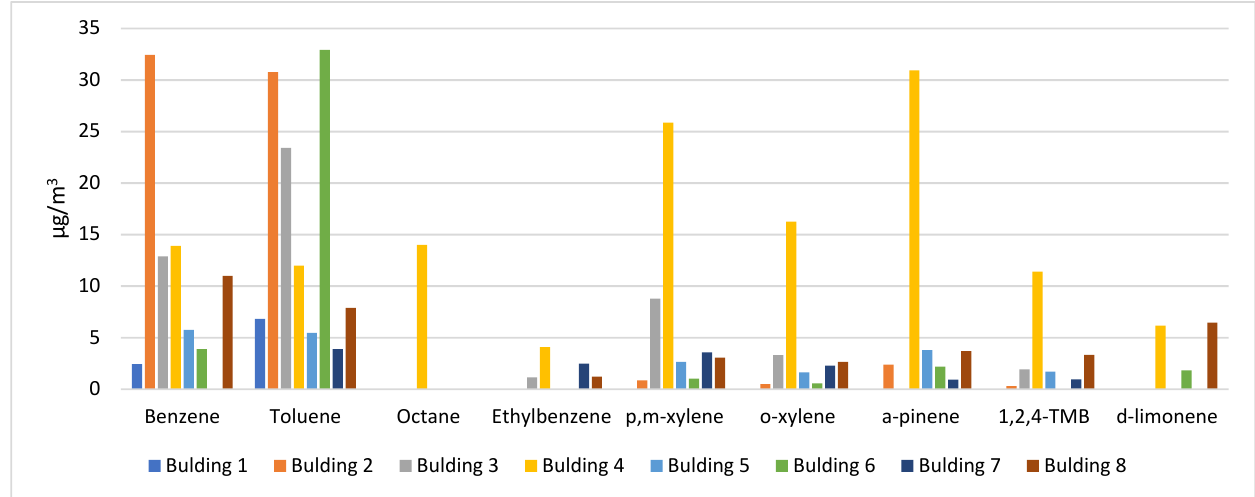
Figure 9. Indoor concentrations (μg m −3 ) of VOCs.